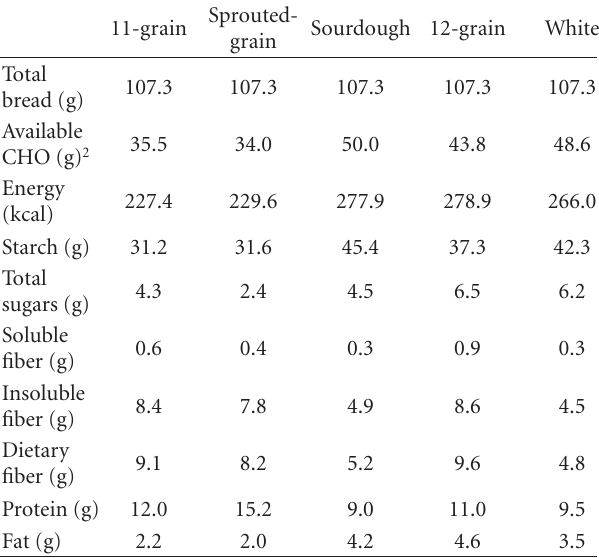
Table 2: Nutrient composition of the test breads delivering a consistent portion size (part 2) 1